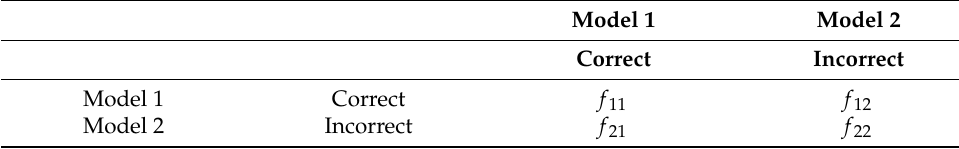
Table 3. Contingency matrix between two